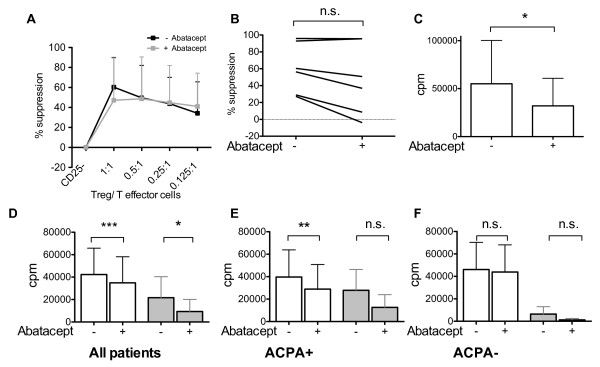
Abatacept reduces T cell proliferation in vitro. (A-C) SFMC from RA patients (n=6) were sorted into CD4+CD25- T effector cells as well as CD4+CD25++ Treg and were co-cultured with CD3-APC for 6 days in the presence of plate-bound α-CD3, either in the presence or absence of 10 μg/ml abatacept. (A) Synovial CD4+CD25- T effector cells were cultured alone and in the presence of different ratios of CD4+CD25++ Treg. The graph depicts the percentage of suppression by CD4+CD25++ Treg in co-culture either in the absence (black line) or the presence of abatacept (grey line). A summary of six experiments is shown and all values are expressed as mean+SD. (B) The graph displays the suppression of proliferation at the 1:1 ratio of T effector cells and Tregs. (C) Proliferation of CD4+CD25- T effector cells alone was measured by thymidine incorporation in the absence or presence of abatacept (n=6). (D-F) SFMC from RA patients were stimulated with α-CD3 (white bars) or influenza vaccine (grey bars) in the presence of 10 μg/ml abatacept or a control compound. Proliferation of SFMC was measured by thymidine incorporation following 72 hours (α-CD3) or 6 days (influenza) in culture. All values are expressed as mean+SD. (D) All patients are displayed, (α-CD3: n=15 patients; Influenza: n=7). (E) Only ACPA-positive patients are displayed, (α-CD3: n=9 patients; Influenza: n=5). (F) Only ACPA-negative patients are displayed, (α-CD3: n=6 patients; Influenza: n=2).